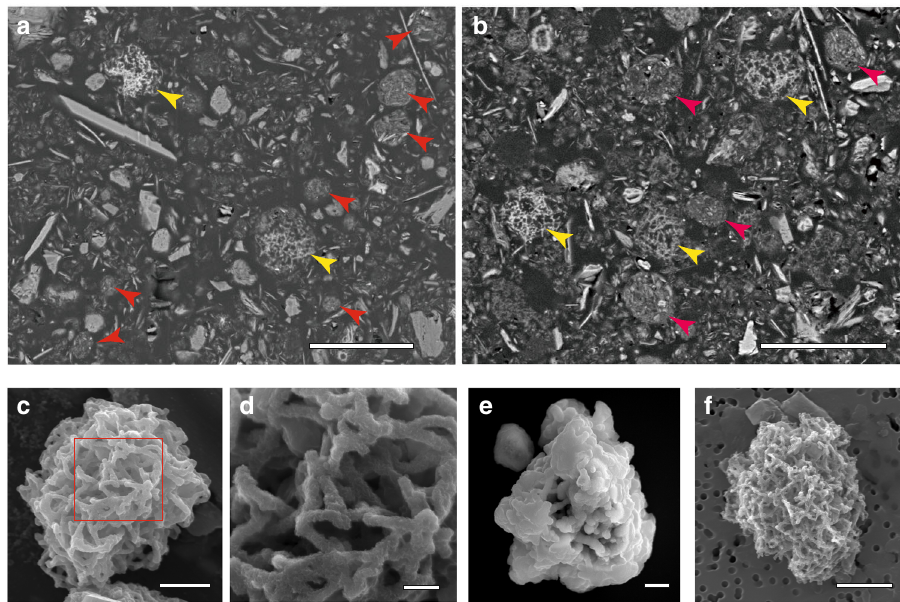
Fig. 1 Representative electron micrographs of microparticles in sediment samples. a , b Cross-sectional scanning electron microscopy (SEM) images of resin-embedded oxic pelagic clay. Arrows indicate Mn-microparticles (yellow) and clay-microparticles (red) (samples U1365C-1H-2 0/20 and U1367D-1H- 2 20/40, respectively). Scale bars, 10 μ m. c SEM image of a Mn-microparticle in a density-separated sample (sample U1365C-1H-2 0/20). Scale bar, 5 μ m. d Enlargement of the area within the red square in ( c ) showing the tangled fi brous strands in a microparticle. Scale bar, 500 nm. e , f SEM images of Mn-microparticles in density-separated samples (samples U1365C-9H-3 35/55 and U1366F-1H-2 40/60, respectively). Scale bars, 5 μ